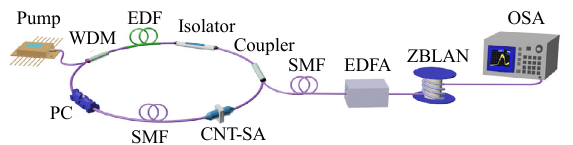
Fig. 1 Experimental setup of spectrally flat supercontinuum generation pumped by the mode-locked laser. CNT-SA: